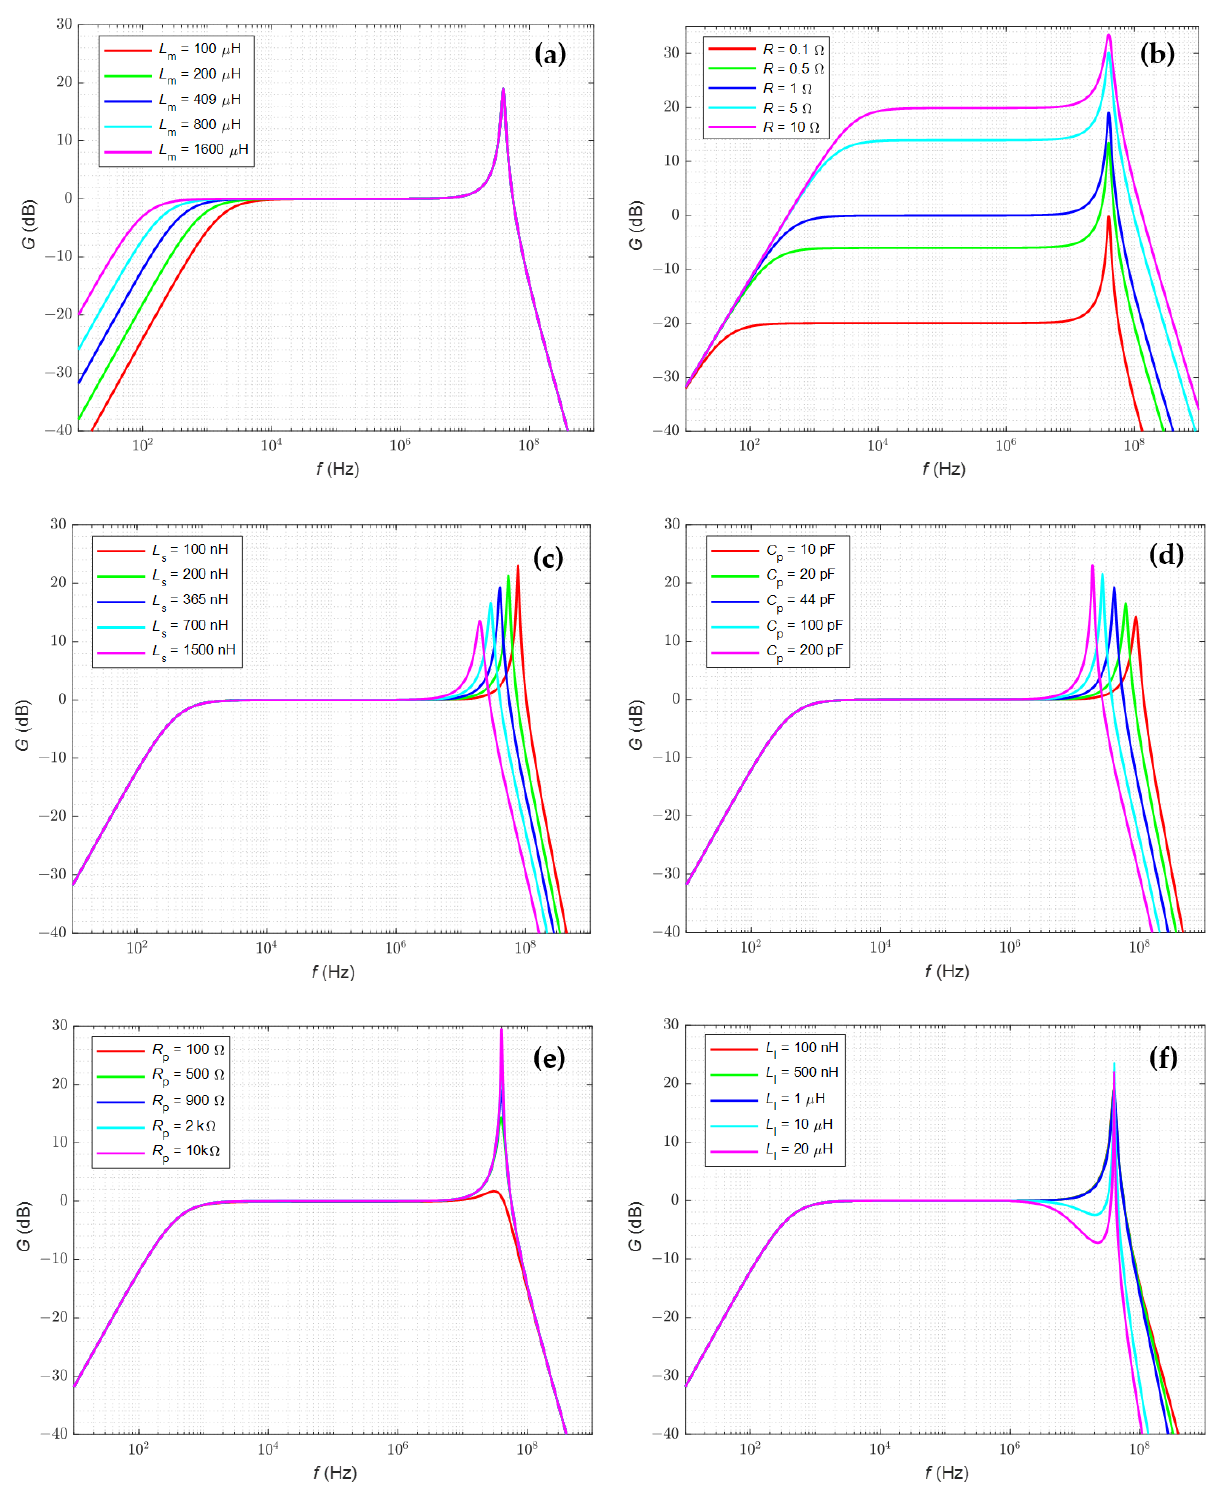
Figure 4. Bode plots of the HFCT model for variable values of the: ( a ) magnetizing inductance, ( b ) burden resistor, ( c ) lead inductance and inductance of the measuring resistor, ( d ) parasitic capacitance, ( e ) core resistance, ( f ) secondary leakage inductance.